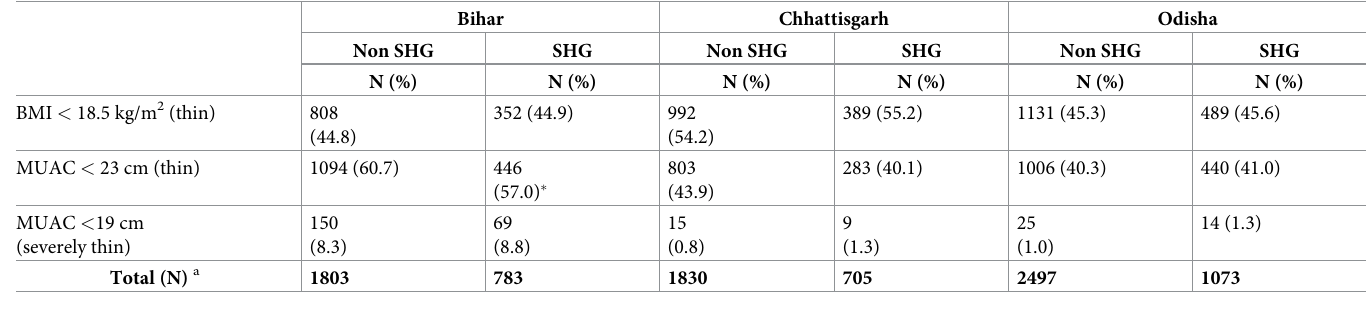
Table 6. Nutritional status of SHG and non-SHG member mothers of children under two years in Bihar, Chhattisgarh and Odisha.